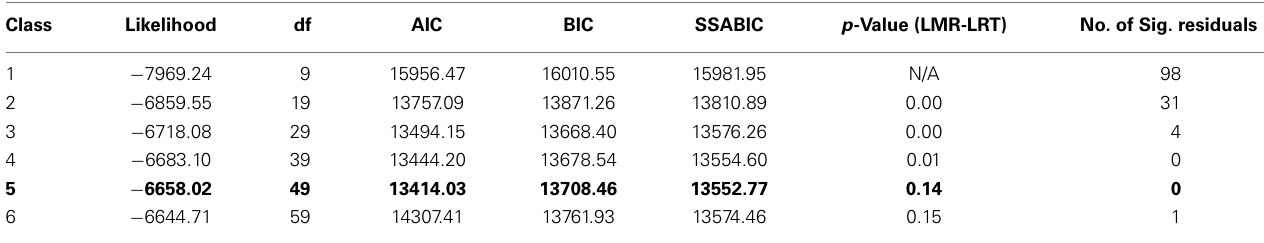
Bolded text indicates the chosen model based on outlined criteria.